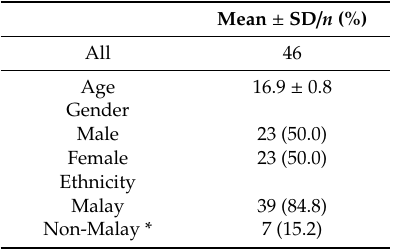
Table 1. Characteristics of study participants.